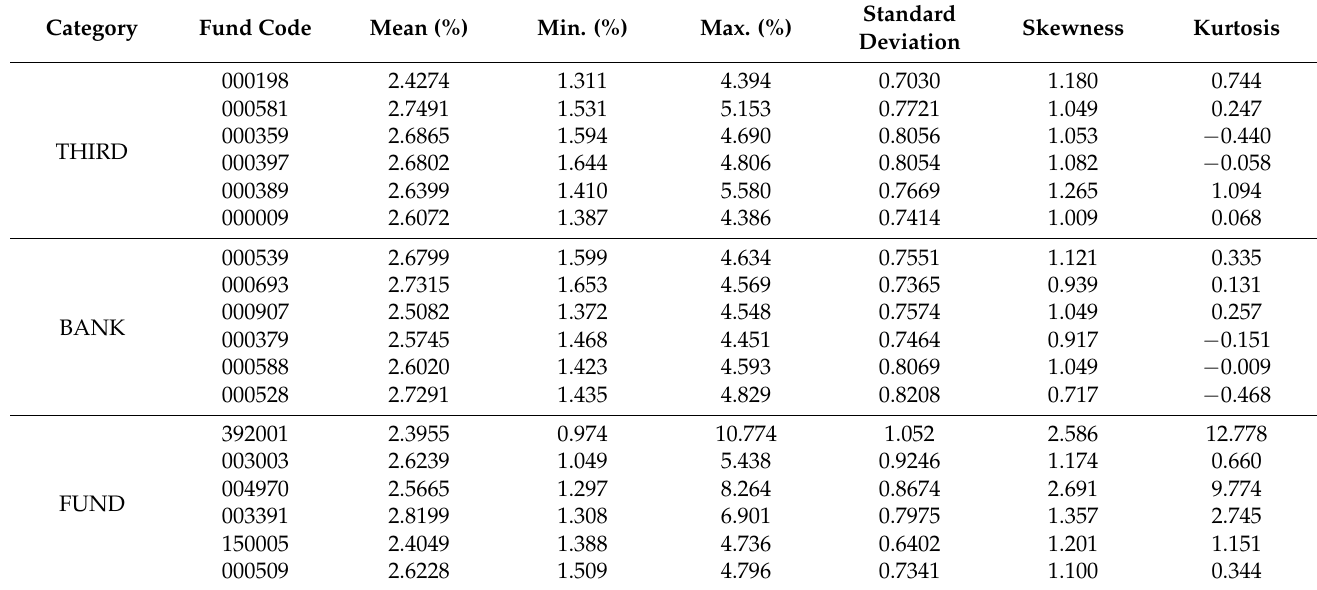
Table 2. Descriptive statistics of return rate